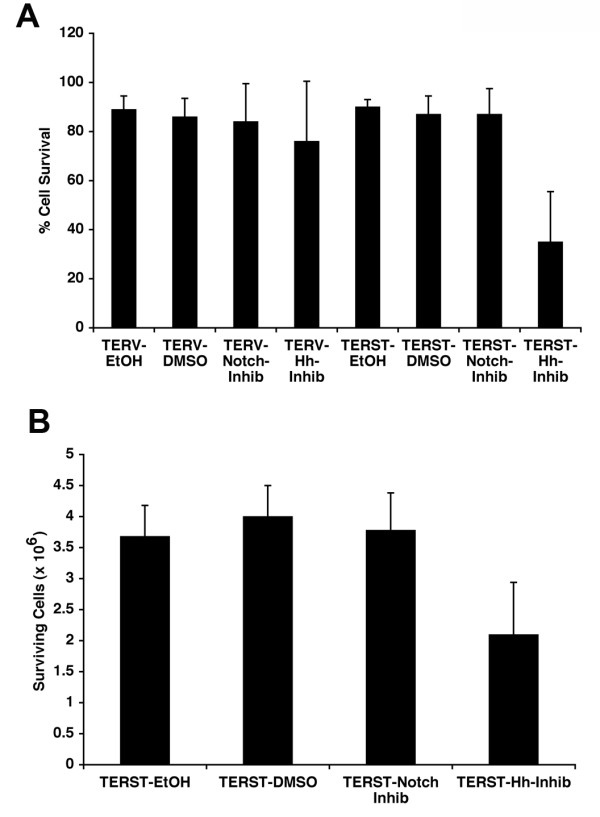
Antitumor activities of cyclopamine and γ-secretase inhibitor against HEKTER-LUK and HEKTER-ST cell lines. (A) Survival of HEK-TERV and HEK-TERST cells determined by MTT assay after treatment with vehicle, 2.4μM Cyclopamine or 1 nM γ-secretase inhibitor for 72 hrs. Mean and standard error are shown for each treatment. Percent cell survival was computed relative to untreated cells. (B) Survival of HEK-TERST cells determined by Trypan Blue exclusion assay after treatment of 1 × 105 cells with vehicle, 2.4μM Cyclopamine or 1 nM γ-secretase inhibitor for 72 hrs.